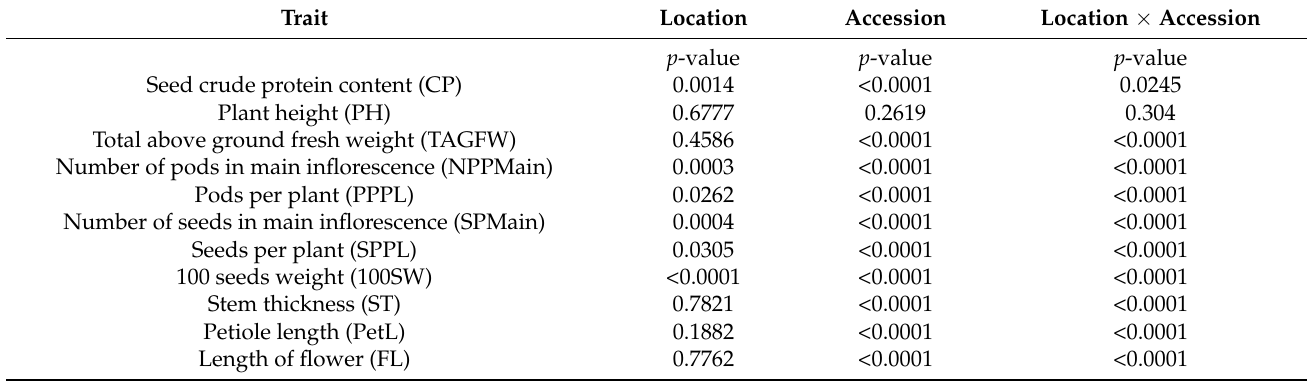
Table 7. Over Location analysis for particular agronomic and morphological traits regarding L. mutabilis accessions white (‘Multitalia’) and narrow-leafed lupin (‘Polo’)